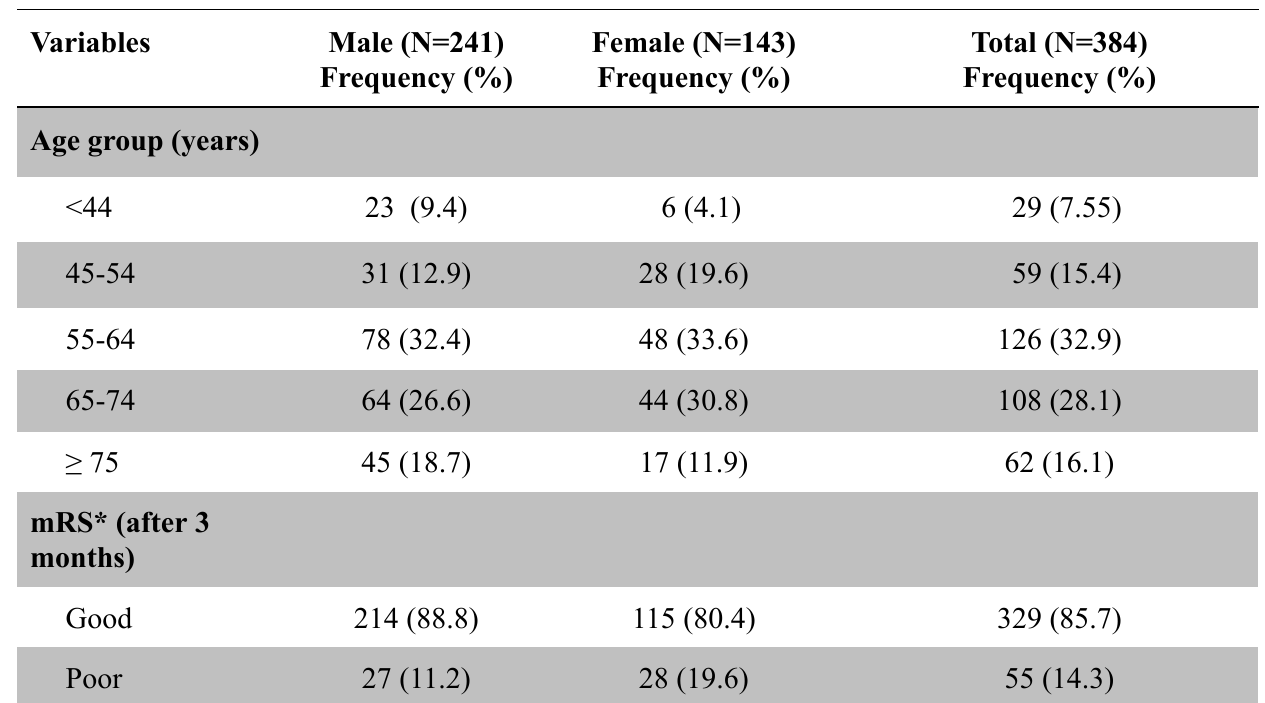
Table1: Baseline characteristics of the study population.